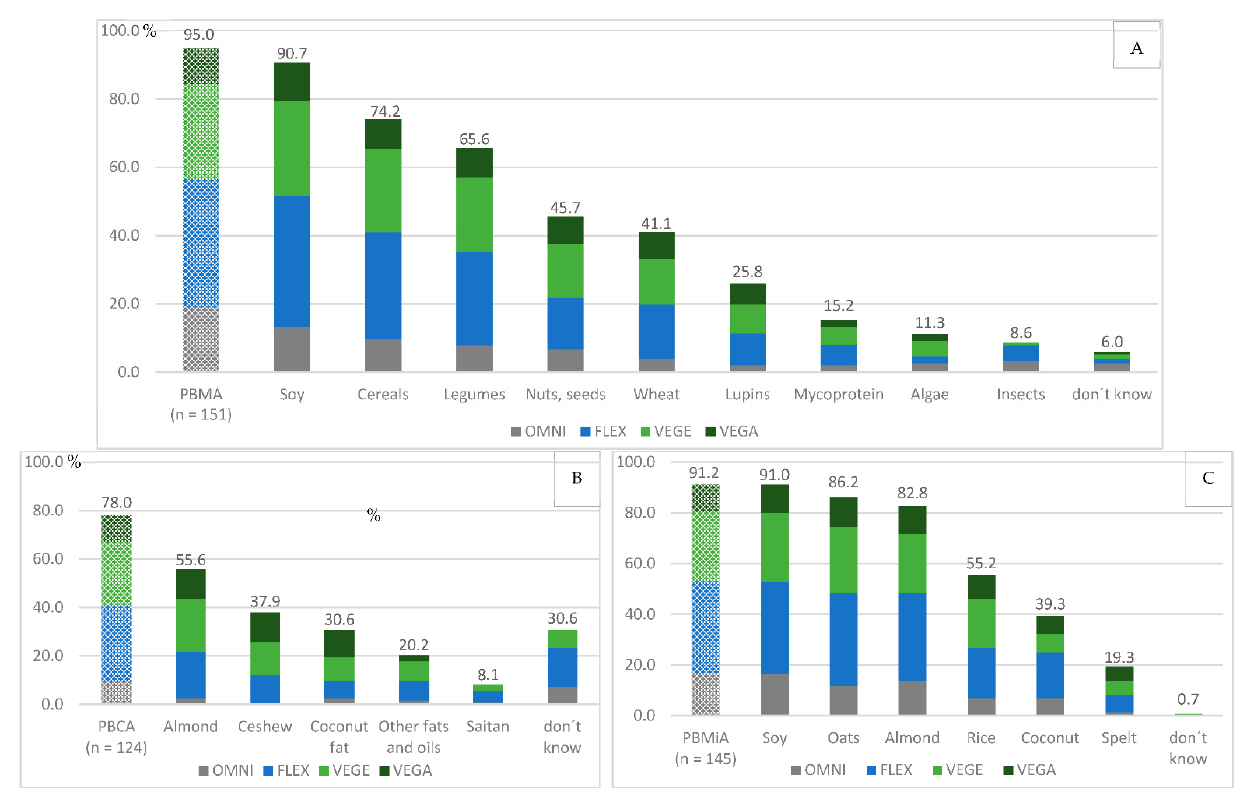
Figure 1. Percentage representation of the basis of the different plant-based alternative products, ( A ) = PBMA (plant-based meat alternative), ( B ) = PBCA (plant-based cheese alternative), ( C ) = PBMiA (plant-based milk alternative); patterned bars represent the total value related to the response of the participants, blank bars relate to the food or raw material basis of the products, with multiple mentions resulting in different percentages. Abbreviations of the nutrition styles: OMNI = omnivore, FLEX = flexitarian, VEGE = vegetarian, VEGA = vegan.